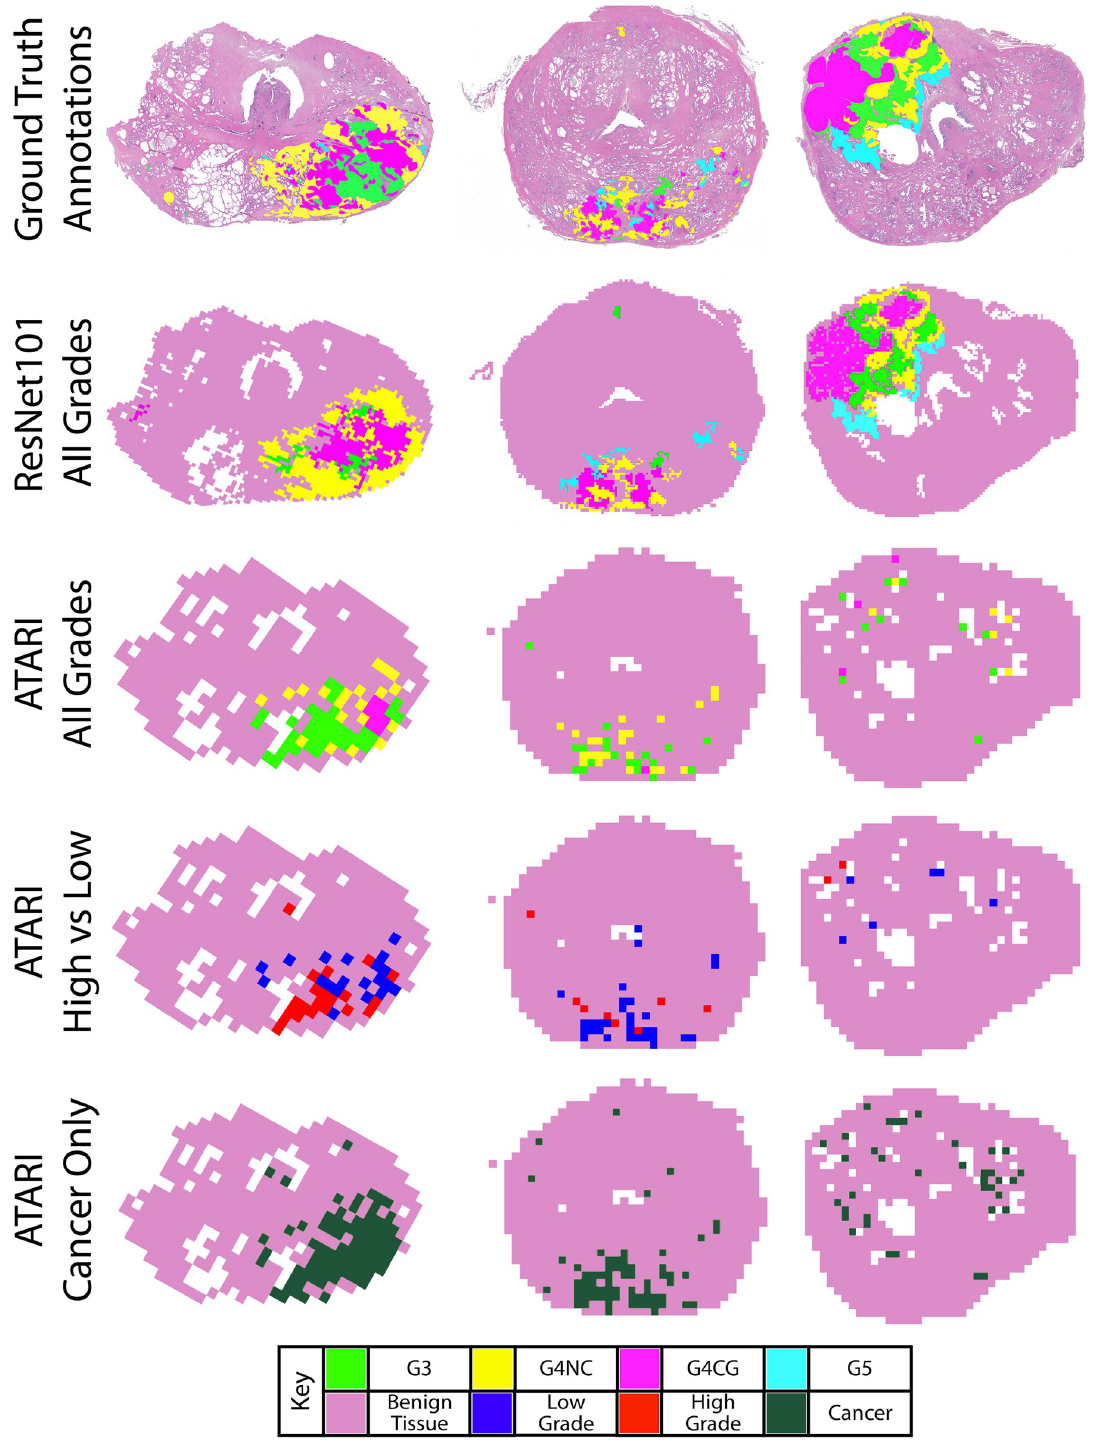
Fig 3. Example annotated slides. Ground truth annotation maps compared to the ResNet101 model for all Gleason grades and the three tested ATARI models: all Gleason grades, high- vs low-grade cancer, and cancer vs non-cancer only.